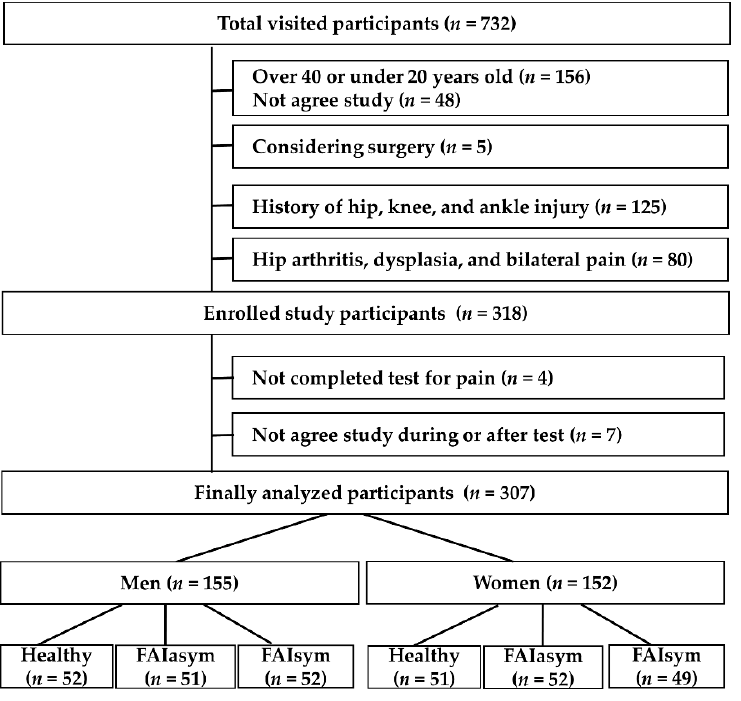
Figure 2. Participant’s exclusion and inclusion process.